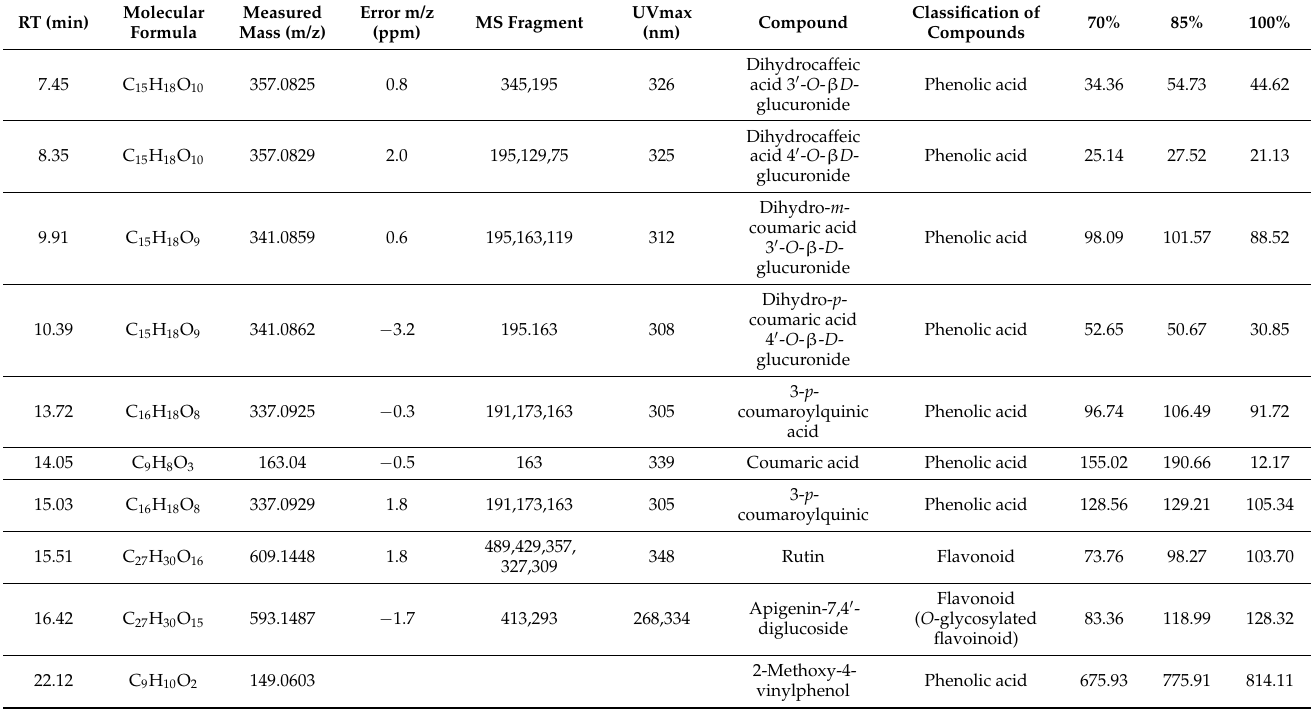
Table 5. Identification and mean abundance of phytochemicals (mg L − 1 ) in the Piper betle extracts using 70%, 85%, and 100% aqueous